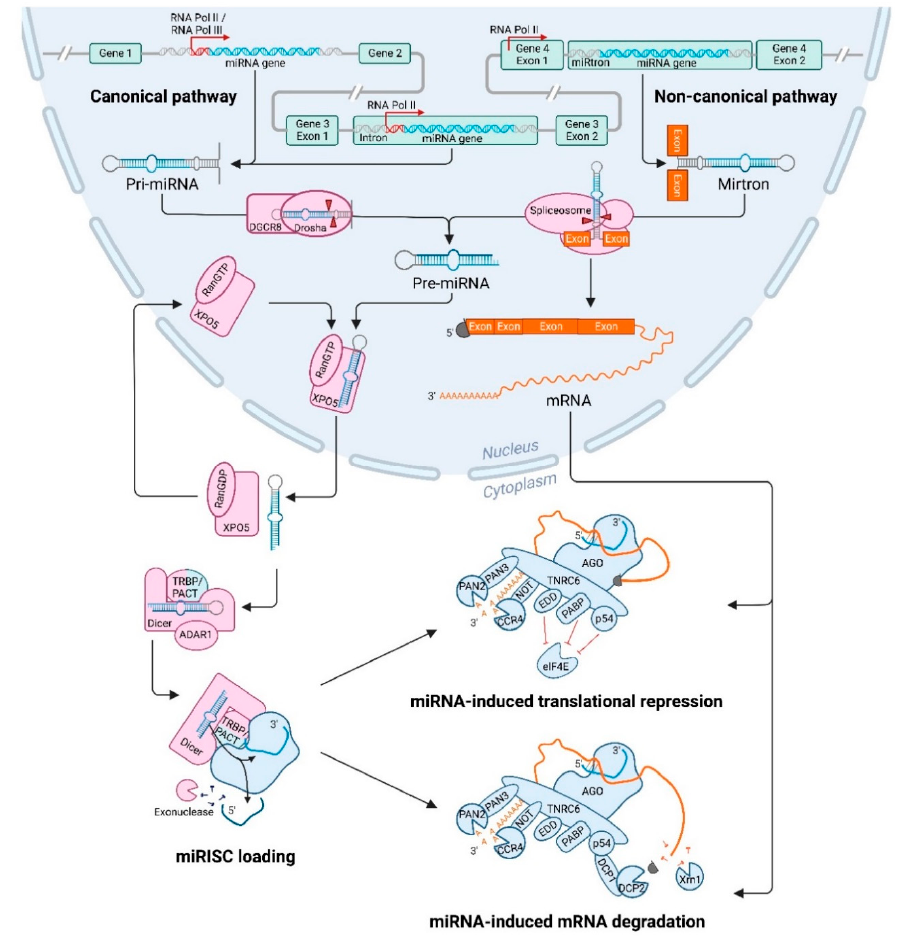
Figure 1. General overview of the canonical and non-canonical route from microRNA gene to regulation of target messenger RNA. Following the canonical pathway of miRNA biogenesis, an intergenic (left), or intragenic (middle) miRNA gene is transcribed by RNA polymerase (Pol) II or III, to a primary-miRNA (pri-miRNA) transcript. This stem-loop transcript is cleaved by ribonuclease III enzyme Drosha and its co-factor DiGeorge Syndrome Critical Region 8 (DGCR8) to form a precursor-miRNA (pre-miRNA), which is subsequently exported out of the nucleus by Exportin-5 (XPO5) and its co-factor Ran-GTP. The non-canonical pathway of miRNA biogenesis involves the splicing of a pre-miRNA molecule from an entire intron without the need for Drosha processing, after which it enters the canonical pathway. In the cytoplasm, the pre-miRNA is cleaved by ribonuclease III enzyme Dicer and its co-factors transactivation-response element RNA binding protein (TRBP), protein kinase RNA activator (PACT) and adenosine deaminases acting on RNA 1 (ADAR1) to form a mature miRNA duplex. After strand selection, a single-stranded guide miRNA is incorporated into Argonaute (AGO), which is bound by trinucleotide repeat containing 6 protein (TNRC6) and then the functional miRNA-induced silencing complex (miRISC) is formed. The passenger strand is released and degraded by an exonuclease. After association with multiple co-factors and miRISC effector proteins, the miRISC is able to silence its target. The miRNA is hereby used as a guide, and based on complementarity between miRNA and messenger RNA (mRNA), translation is repressed or the mRNA is degraded. Binding of the miRISC to the target mRNA can induces deadenylation by CCR4-NOT as main effector, which is in some cases followed by decapping by DCP1/DCP2 and degradation by exonuclease XRN1 (Created with